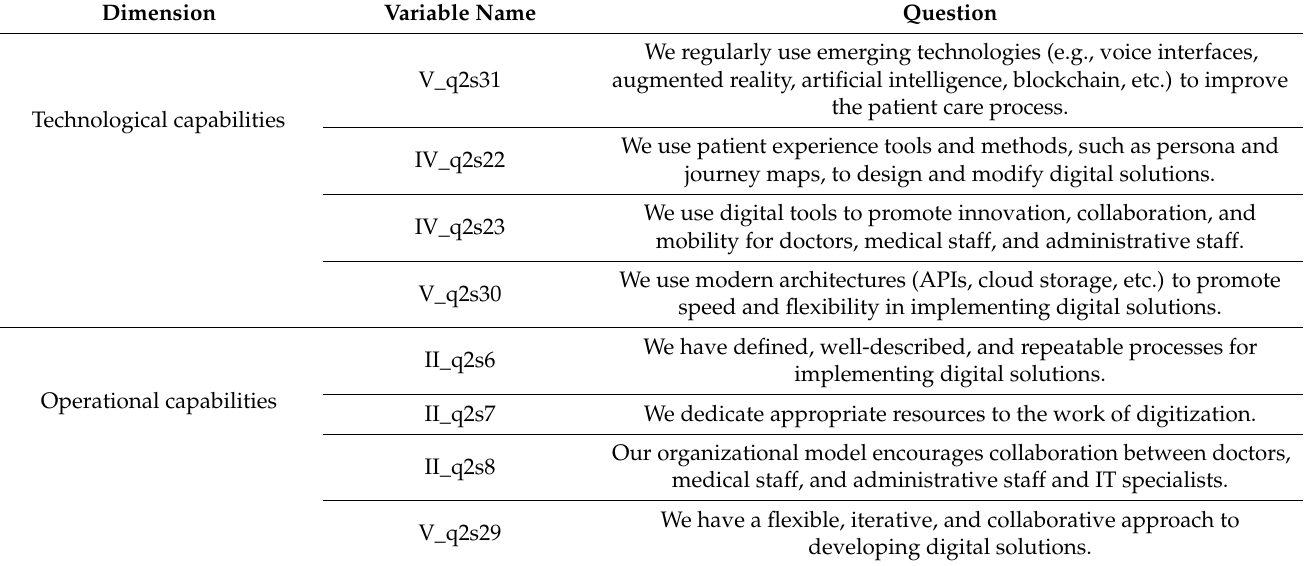
Table 3. Survey questions for OC and TC